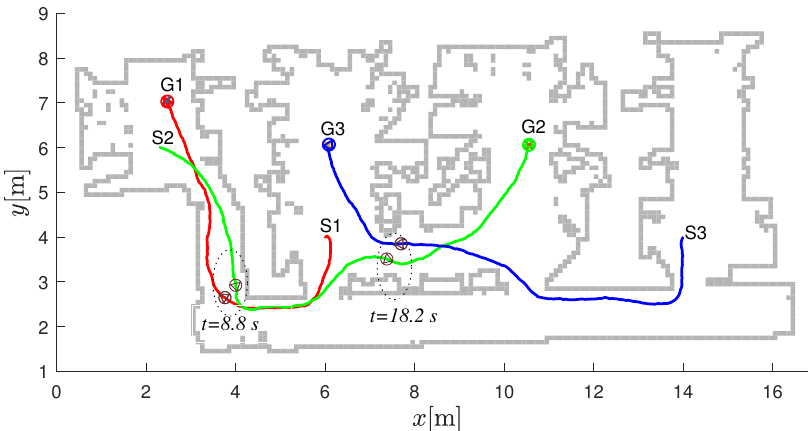
Figure 15. Robot paths in the laboratory layout. The start location of the i -th robot is denoted by S i and the destination locations by G i . Safe navigation during collision avoidance is represented by dark gray circles belonging to passing robots at the same time (the left pair of circles belongs to time t = 8.8 s and the right pair to time t = 18.2 s).